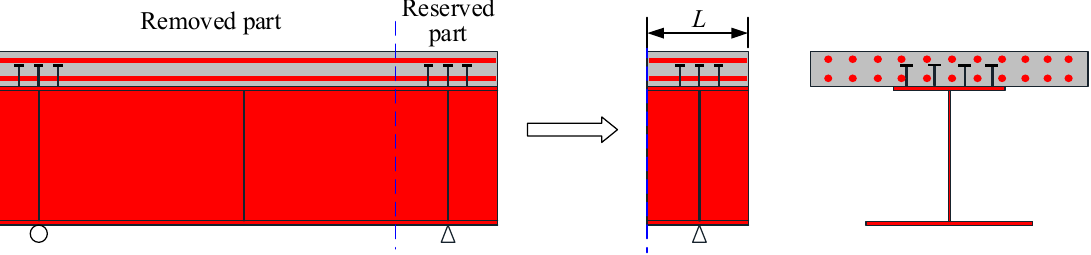
Figure 11. Finite element model of specimens with existing damage.